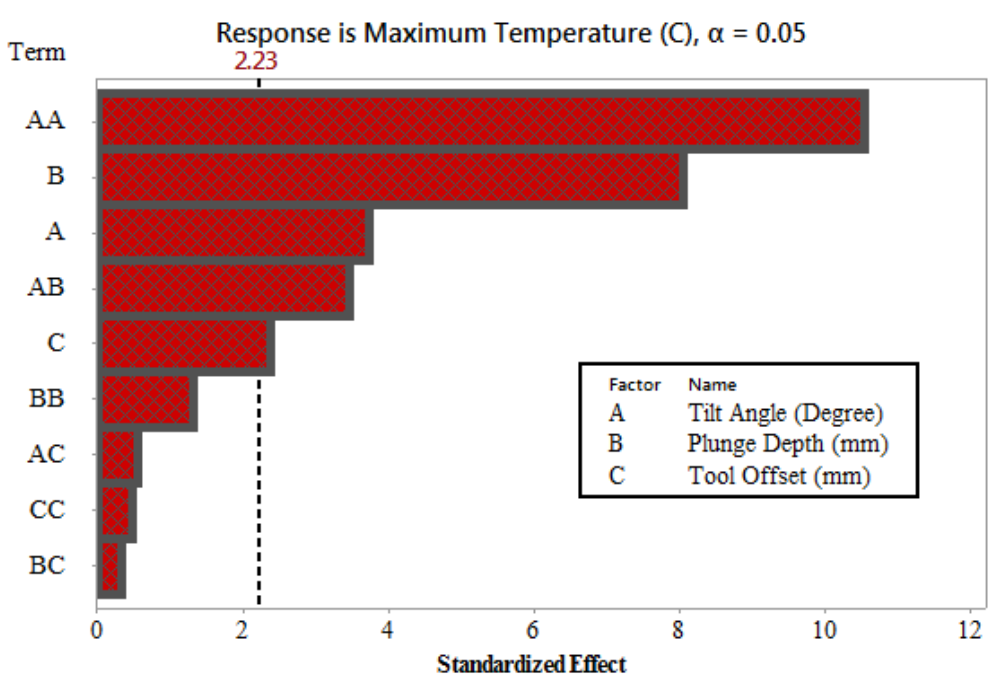
Figure 7. Pareto chart to evaluate the effectiveness of different terms.